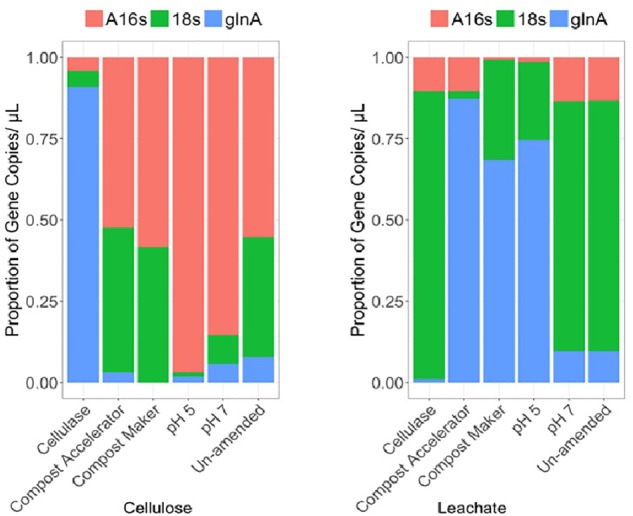
Community differences for cellulose and leachate by differential relative abundances of gene copies detected within the surrogate waste for: Archaeal rRNA (A16S), fungal rRNA (18s), and bacterial glutamine synthetase (glnA), genes.